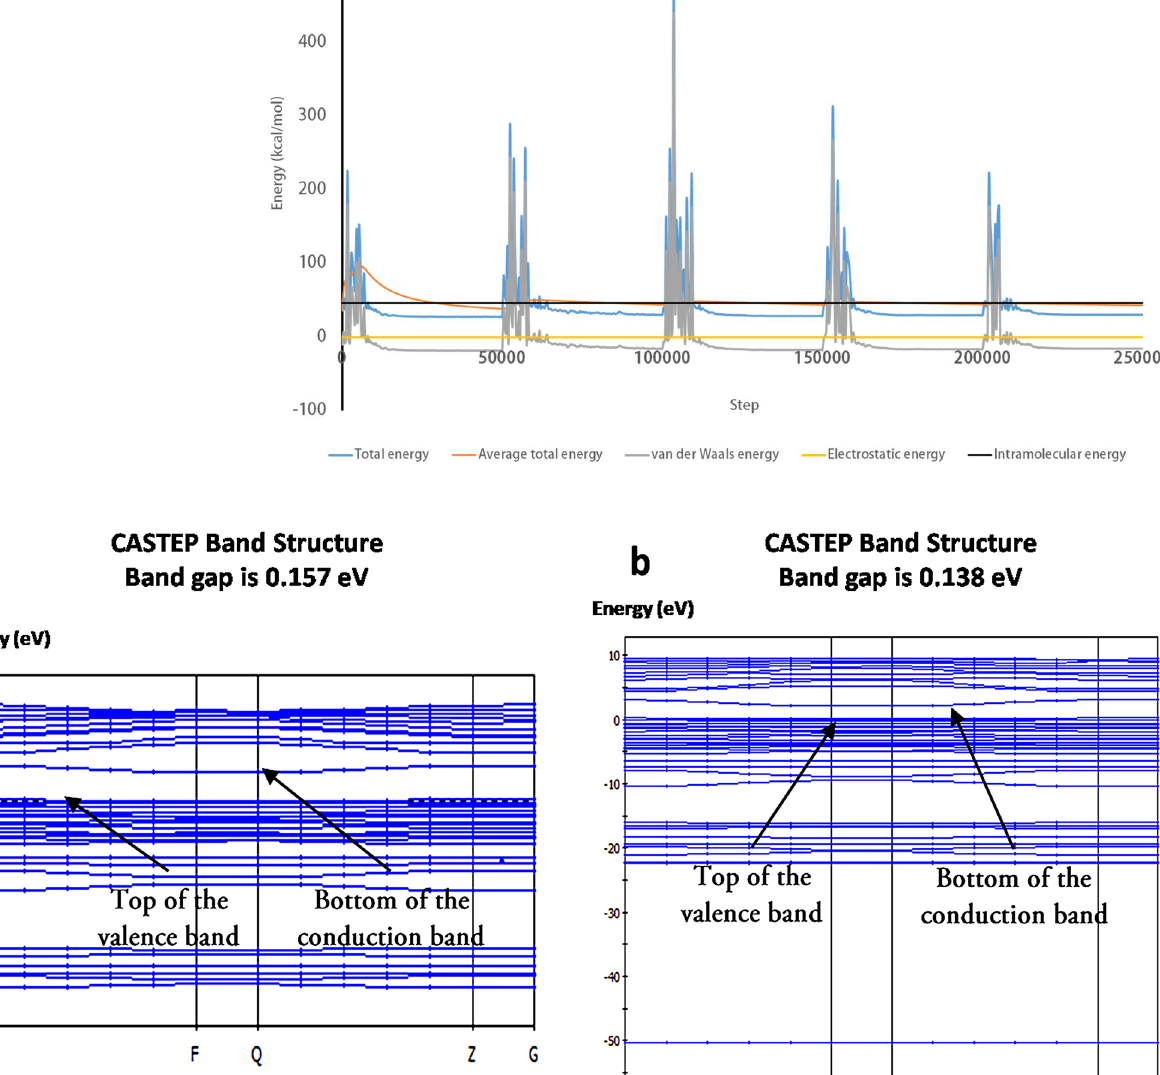
Fig. 8 The different kinds of energy involved in the adsorp- tion NaOH on cleaved quartz